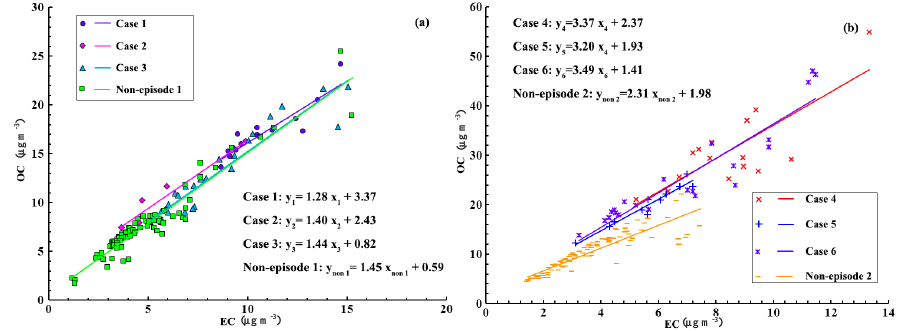
Figure 5. Regression between OC and EC with the 10% lowest OC / EC ratios during (a) summer and (b) autumn in Wuhan.